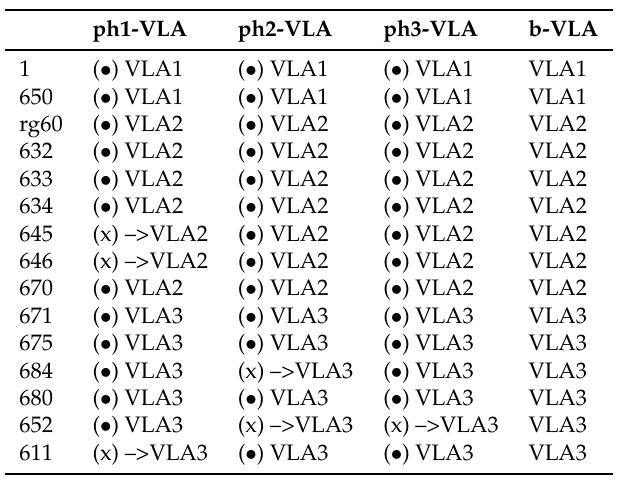
Table 1. Small grid—VLAs per phase and per bus.